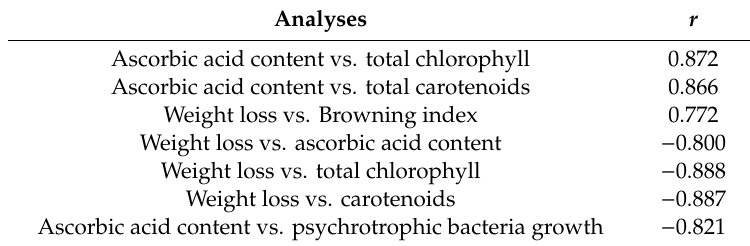
Table 1. Pearson correlation ( r ) between the traits. R values > 0.7 were significant at P <